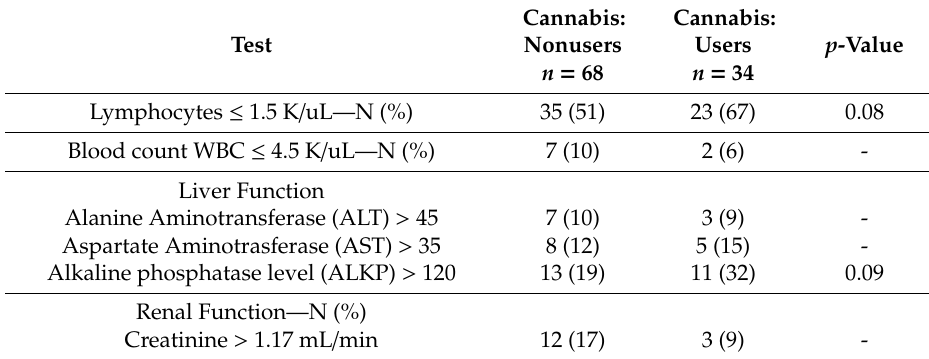
Table 2. Abnormal laboratory tests before immunotherapy (according to local normal